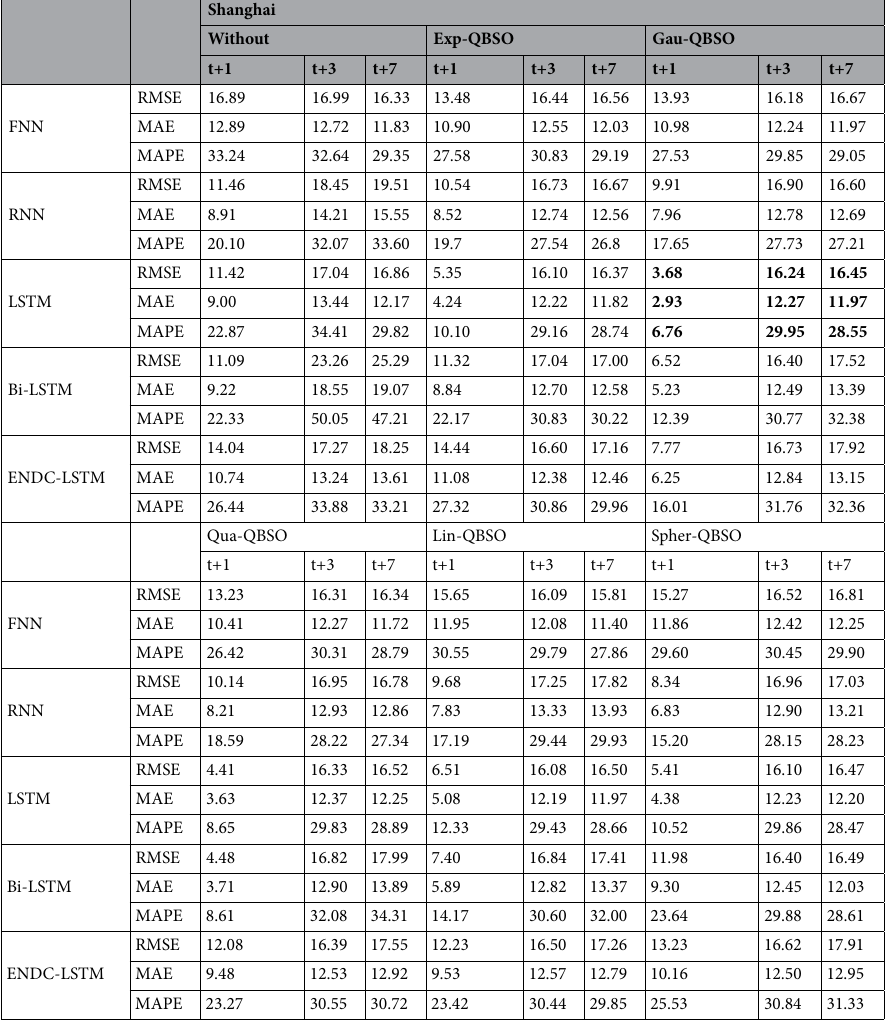
Table 10. The results of the proposed framework for Shanghai. Significant values are in